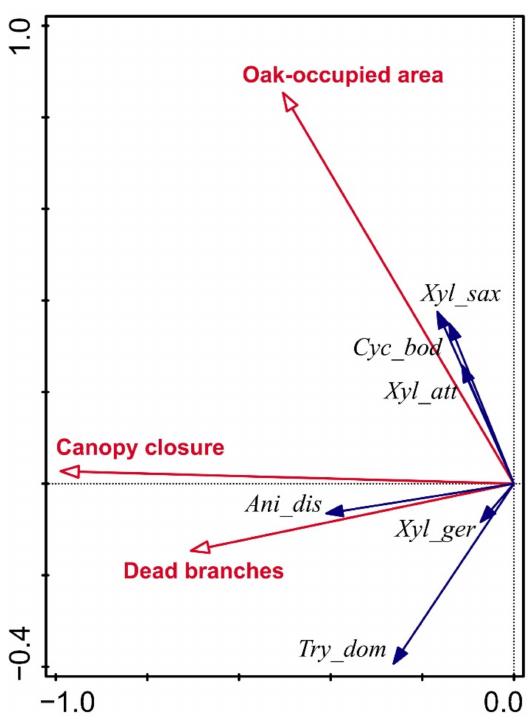
Figure 6. Results of redundancy analysis (RDA) of the relationship between presence of the ambrosia beetle species (blue arrows) and the most important characteristics of forest stand (red arrows). The species and the forest stand characteristics have been abbreviated to simplify the plot. The shown projection of the 1st and the 2nd axes represents 23.8% of the variability in species occurrence.